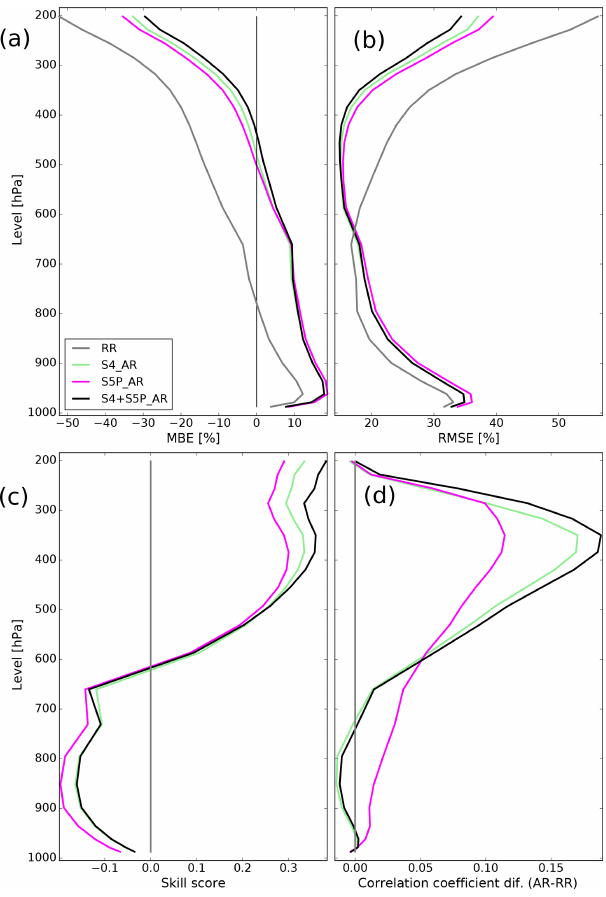
Figure 7. Ozone MBE (%), RMSE (%), skill score, and correlation coefficient difference (assimilation runs minus reference run) mean profiles for summer 2003 (JJA) over the European domain (a, b, c, d) corresponding to the reference run (grey lines), the S4_AR (green lines), the S5P_AR (magenta lines), and the S4+S5P_AR (black